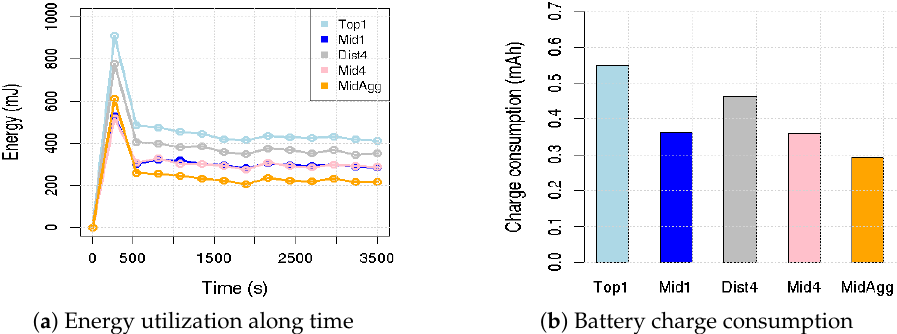
Figure 10. Metrics for the communication models. ( a ) Average energy utilization of a single node. ( b ) Battery charge consumption for one hour.